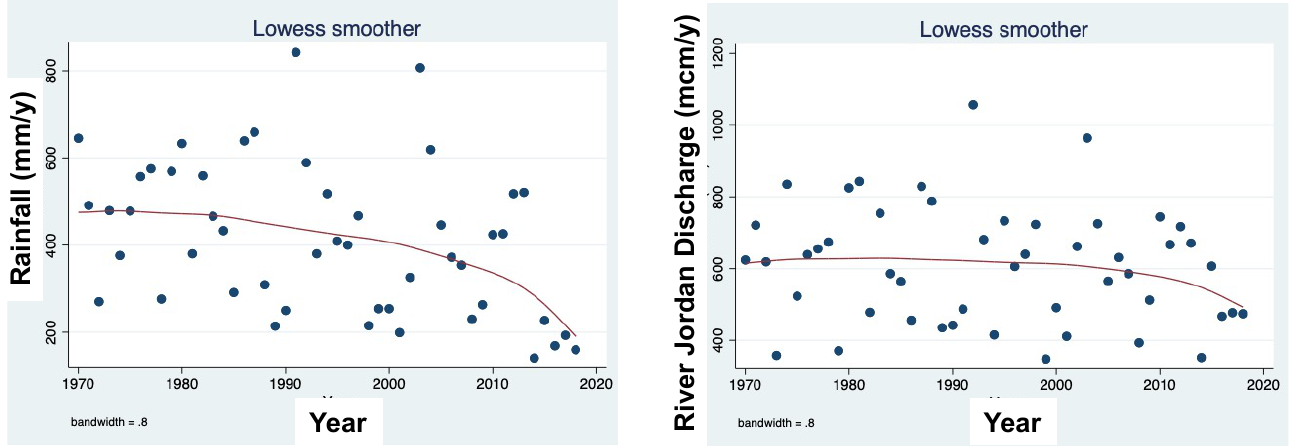
Figure 2. Temporal changes in climate conditions in the Kinneret watershed. ( right ) rainfall (mm/y); ( left ) Jordan River discharge (mcm/y). LOWESS Smoother (bandwidth 0.8).